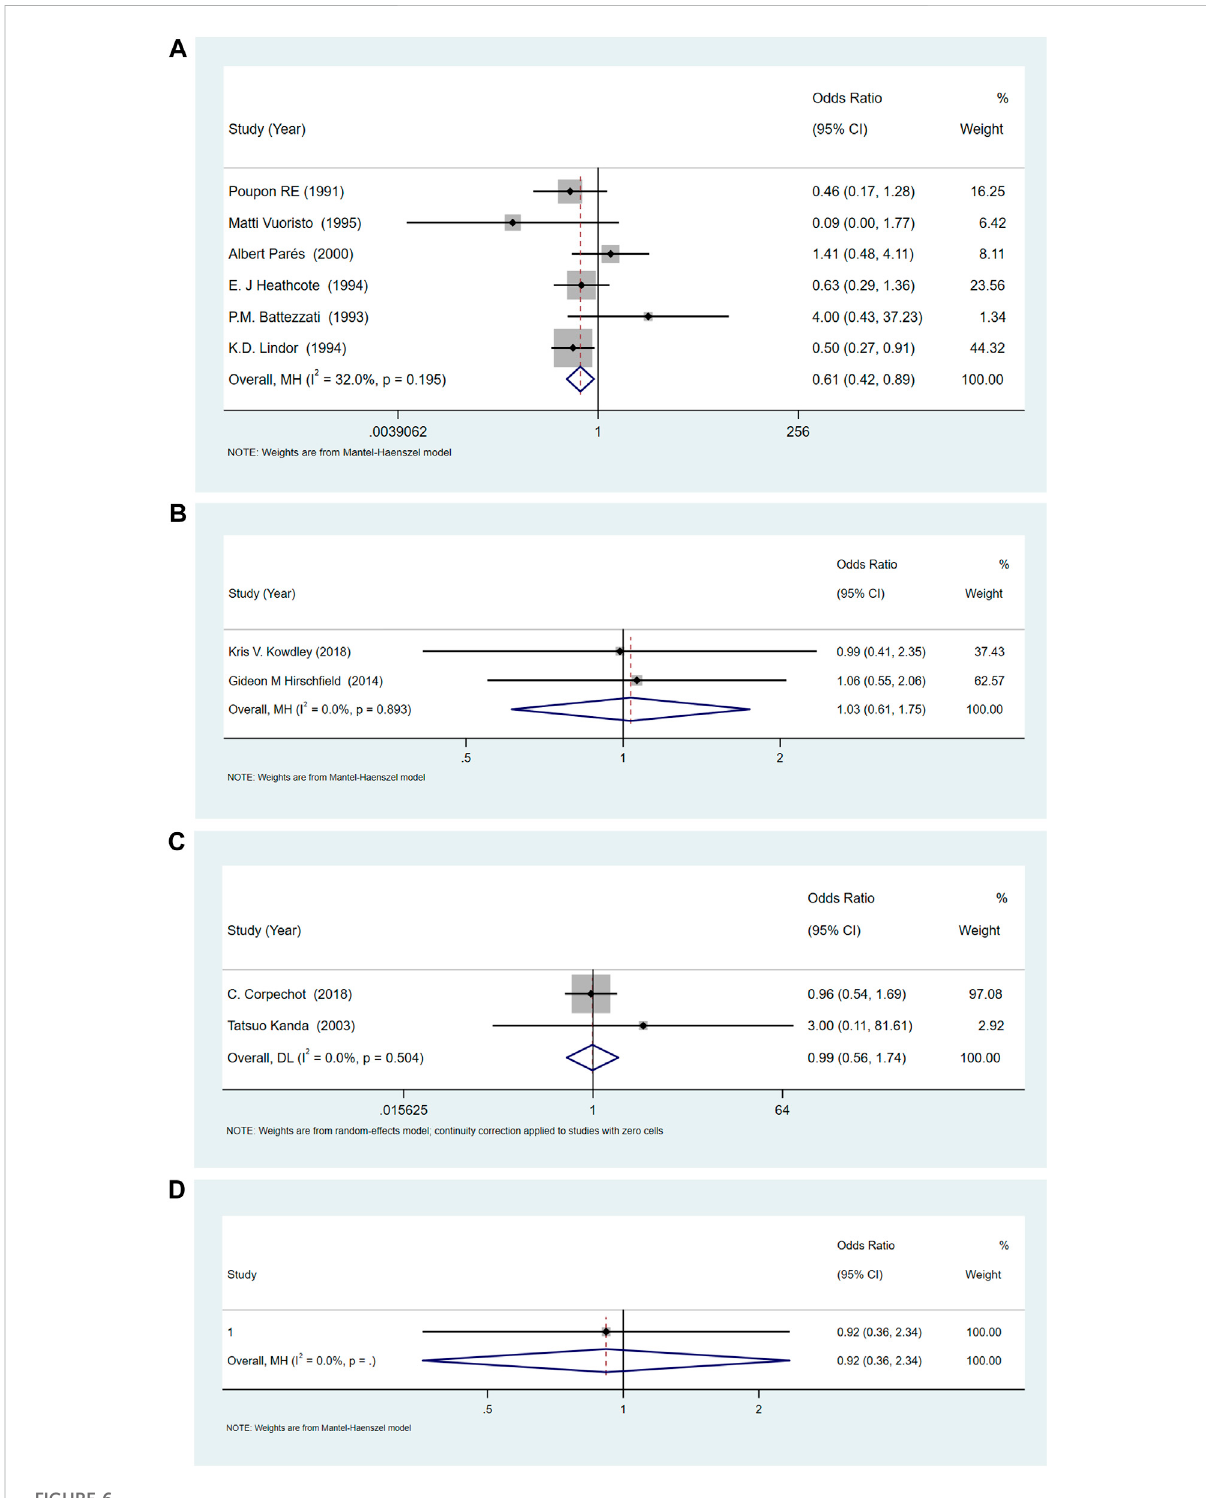
FIGURE 6 (A) The adverse events for UDCA. (B) The adverse events for OCA. (C) The adverse events for Beza fi brate. (D) The adverse events for